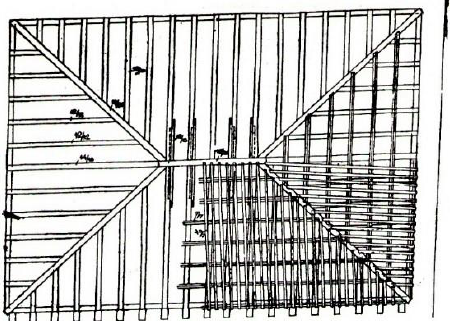
Figure 18. Hipped roof